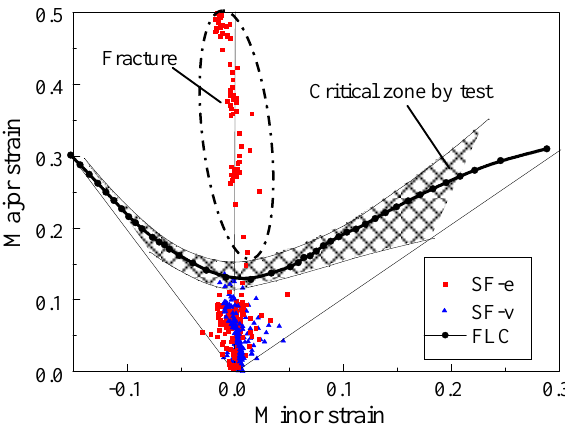
Figure 19. Strain distributions of the critical section of fracture in the stretch-forming process.